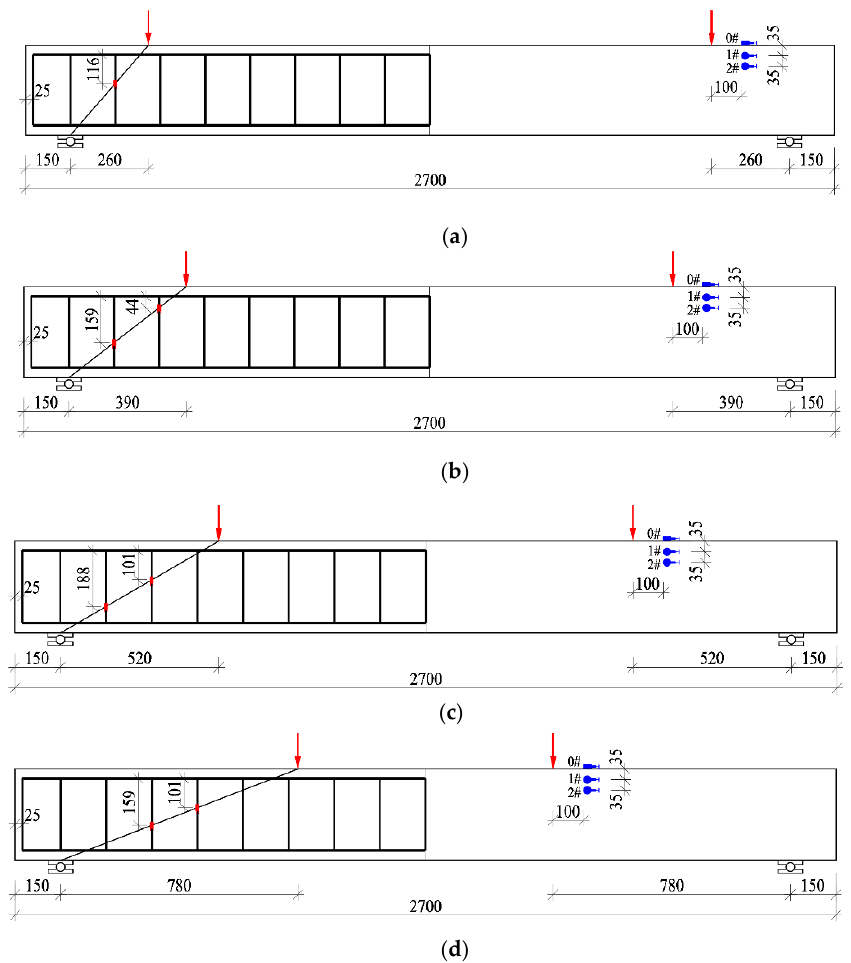
Figure 2. Arrangement for strain gauges of concrete and stirrups: ( a ) λ = 1; ( b ) λ = 1.5; ( c ) λ = 2; ( d ) λ = 3.